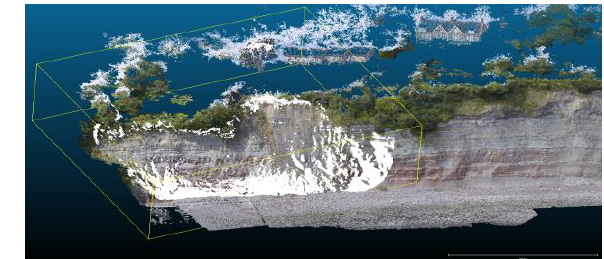
Figure 13. Pole Survey Point Cloud The X, Y, and Z coordinates of some points at the top, sides, and at the bottom of the pole and TLS point clouds, read off,